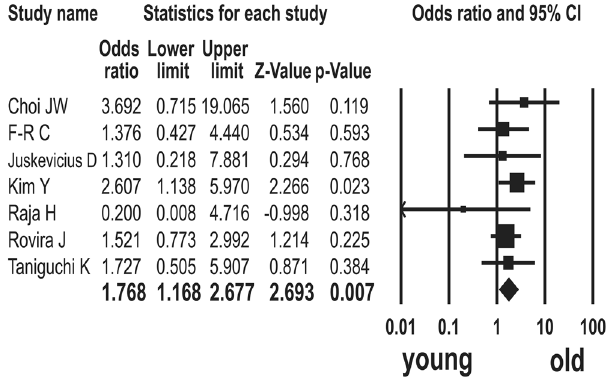
Figure 1. Odds ratios (ORs) with corresponding 95% confidence intervals (CIs) of individual studies and pooled data for the association between MYD88 L265P mutation and old age. The forest plot demonstrates each study and overall effect sizes and 95% CIs.